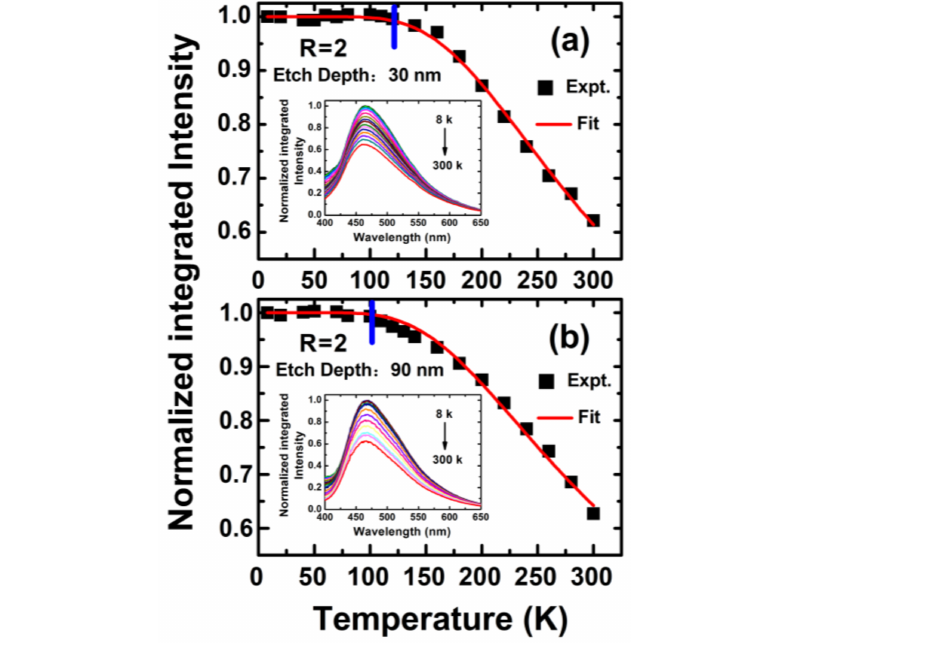
Figure 8. Normalized integrated TD-SSPL intensities of a-SiN x O y thin films (R = 2) with surface etch depths ( a ) 30 nm and ( b ) 90 nm, respectively. Red line: Theoretical fitting results of the TD-SSPL intensities of a-SiN x O y thin films; Blue line: The temperature inflection points of luminescence thermal quenching. The inset shows the related measured TD-SSPL